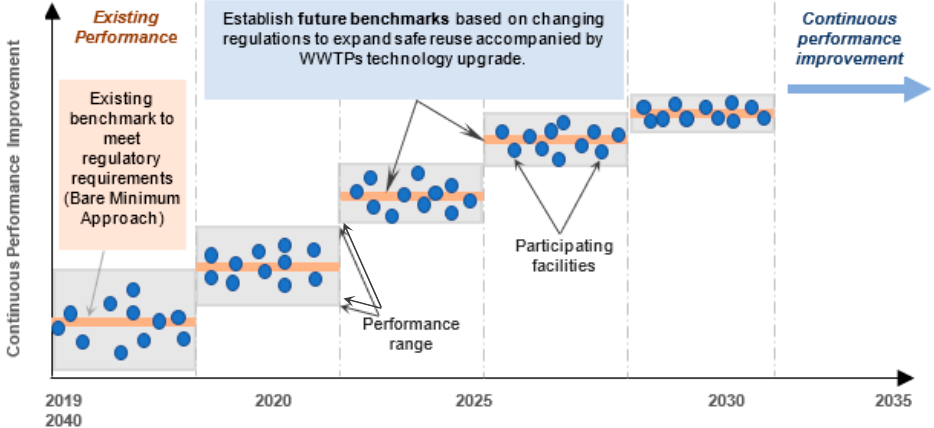
Figure 3. The concept illustrating continuous performance improvement for wastewater treatment facilities in arid regions (modified after [8]).